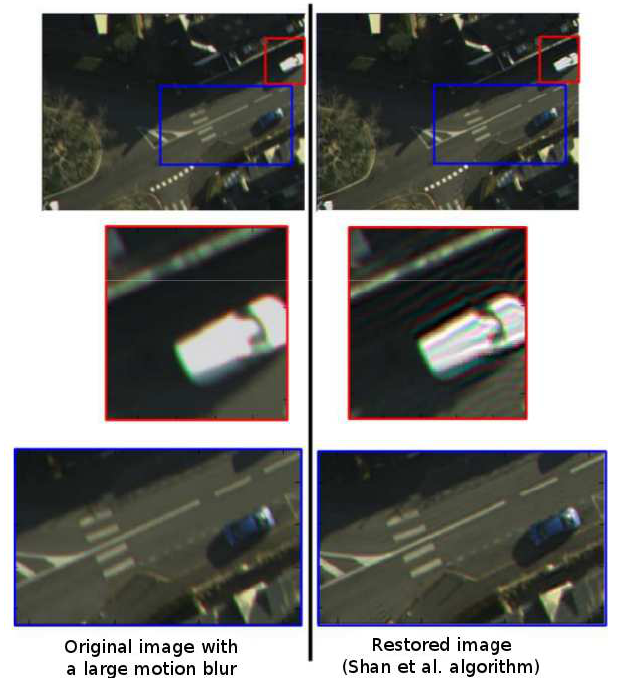
Figure 7. Result of the blur correction step using the iterative approached developed by (Shan et al., 2008) Left: the original image. Right: the restored image.